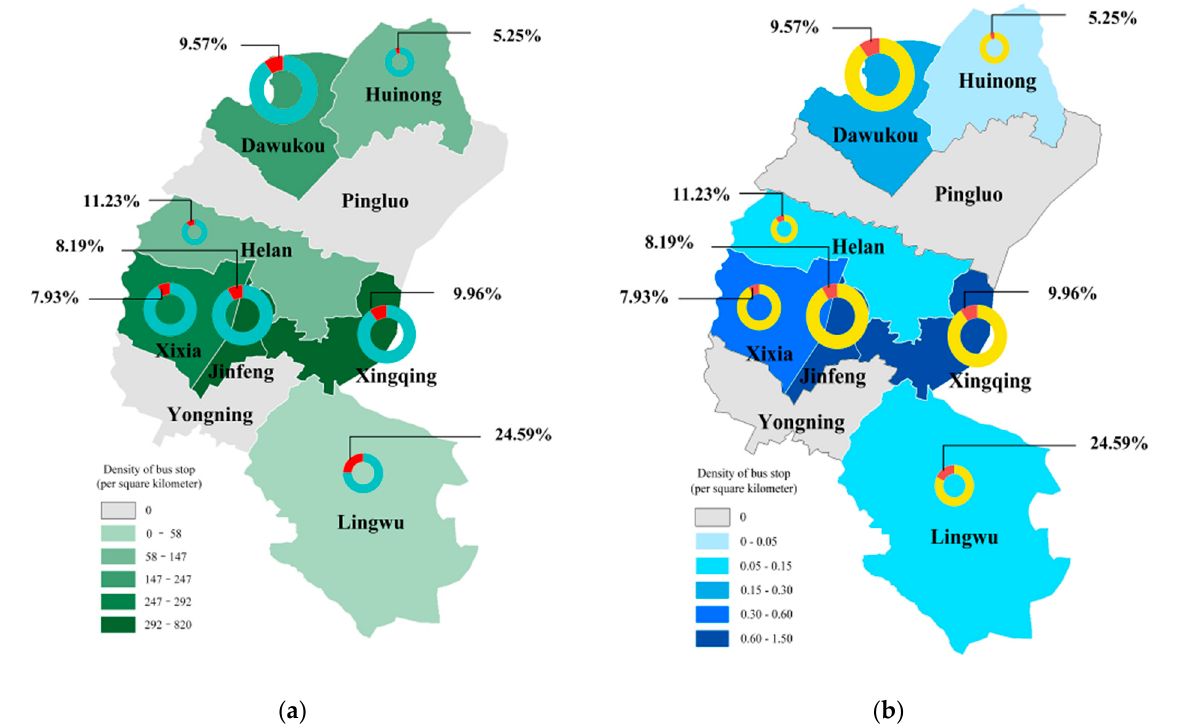
Figure 4. (a) Distribution of population density; ( b ) Distribution of bus stop density. In Figure 4, the shades of color represent the population density and bus stop density, while Pingluo and Yongning Counties are painted in grey because they are not included in the data set. The size of each ring chart represents the intercity ridesplitting demand, and red indicates the proportion of single rides.